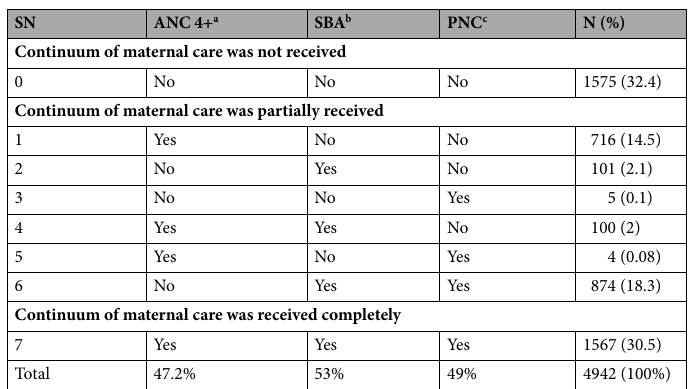
Table 2. Percent distribution of women who had a birth in the past 3 years preceding the survey by different types of maternal health services received for the most recent birth: Bangladesh Demography and Health Survey 2017–2018 (n = 4942). Yes received the service, no did not receive the service. a ANC 4+ = Four or more ANC visit. b SBA = Skilled birth attendant such as qualified doctors, nurses, midwives, or paramedics, family